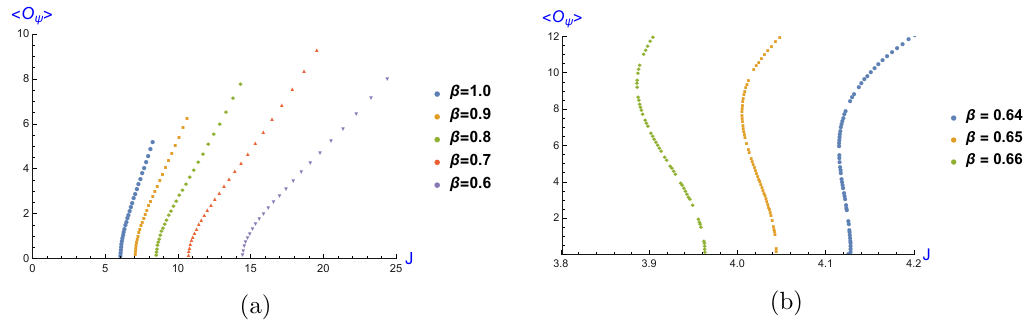
Figure 2. Plots between h O i and J as we vary the strength of mutual coupling (cid:12) and (cid:21) . In (a), we have chosen (cid:21) = 0, (cid:11) 1 = 1 = (cid:11) 2 and the value of (cid:12) has been varied from 0 : 6 to 1 : 0. In (b) we have taken (cid:12) = 0, (cid:11) 1 = 0 : 1 = (cid:11) 2 and (cid:21) = 0 : 64 ; 0 : 65 ; 0 : 66